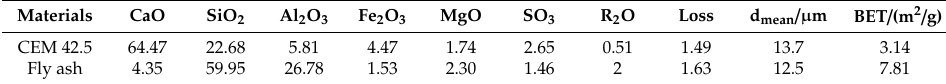
Table 1. Chemical composition and physical properties of Portland cement and fly ash.